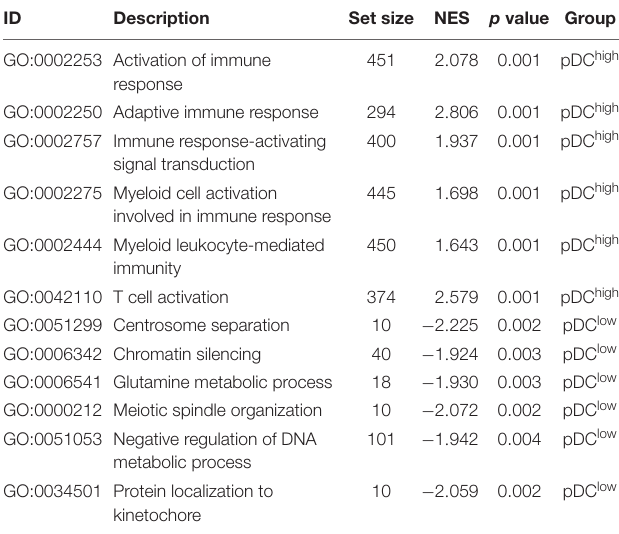
TABLE 3 | The enriched GO pathways associated with the pDC in